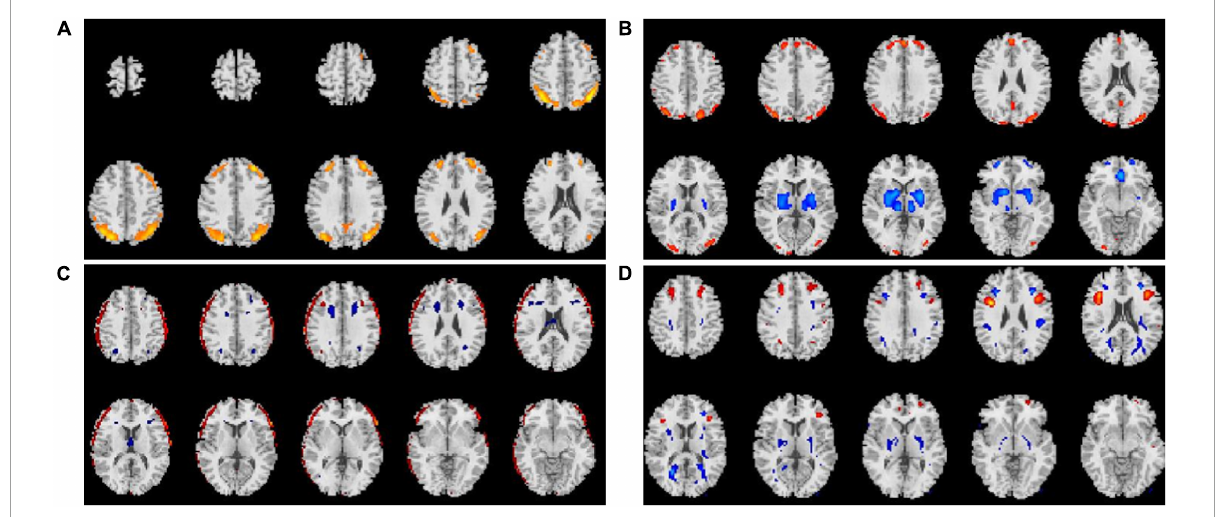
FIGURE1 Comparison of gFCDs before versus after 24-week treatments inclusive of f-DCS. (A) O-tDCS + Li group. (B) O-tDCS group. (C) F-fDCS + Li group. (D) F-tDCS